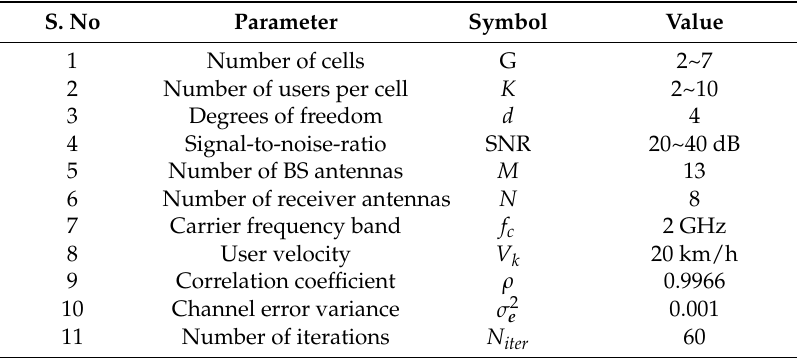
Table 1. Proposed System Simulation